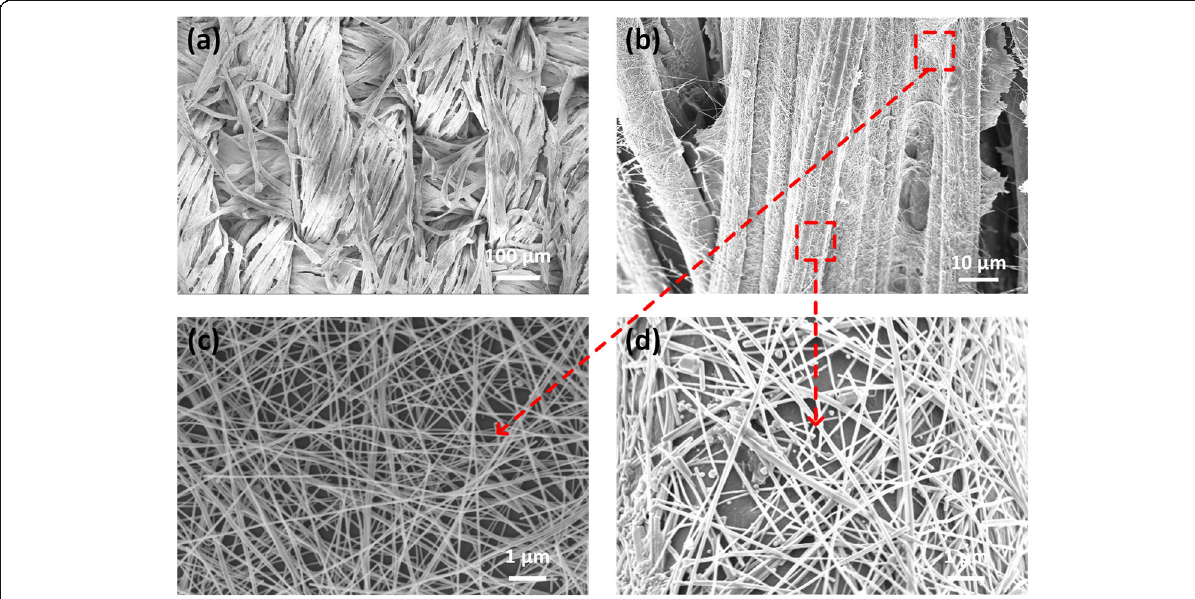
Fig. 2 The morphology of the AgNWs-coated fabrics. a – d The SEM images of the surface morphology of AgNWs-coated fabric with different position of AgNWs and different magnification, in which c is the SEM image of the AgNWs between the yarns and d the AgNWs coated on the single